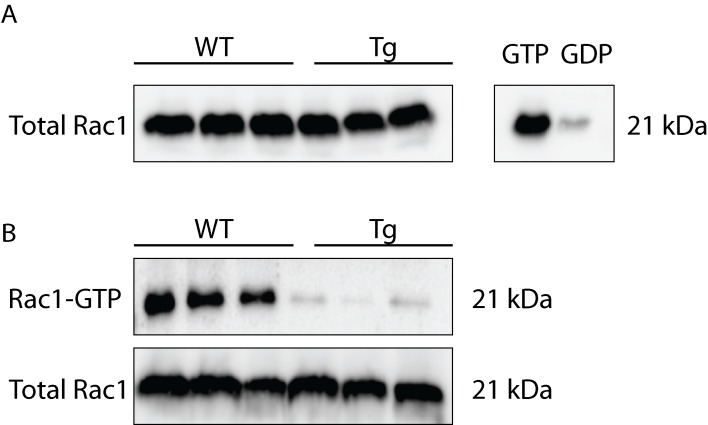
HIV-Tg rats show reduced levels of activated Rac1 and no changes in total Rac1 protein expression in frontal cortex lysates.